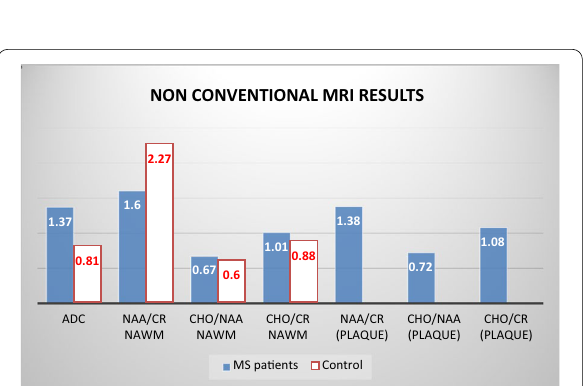
Fig. 1 Difference between patients with and healthy controls as regard non‑conventional MRI